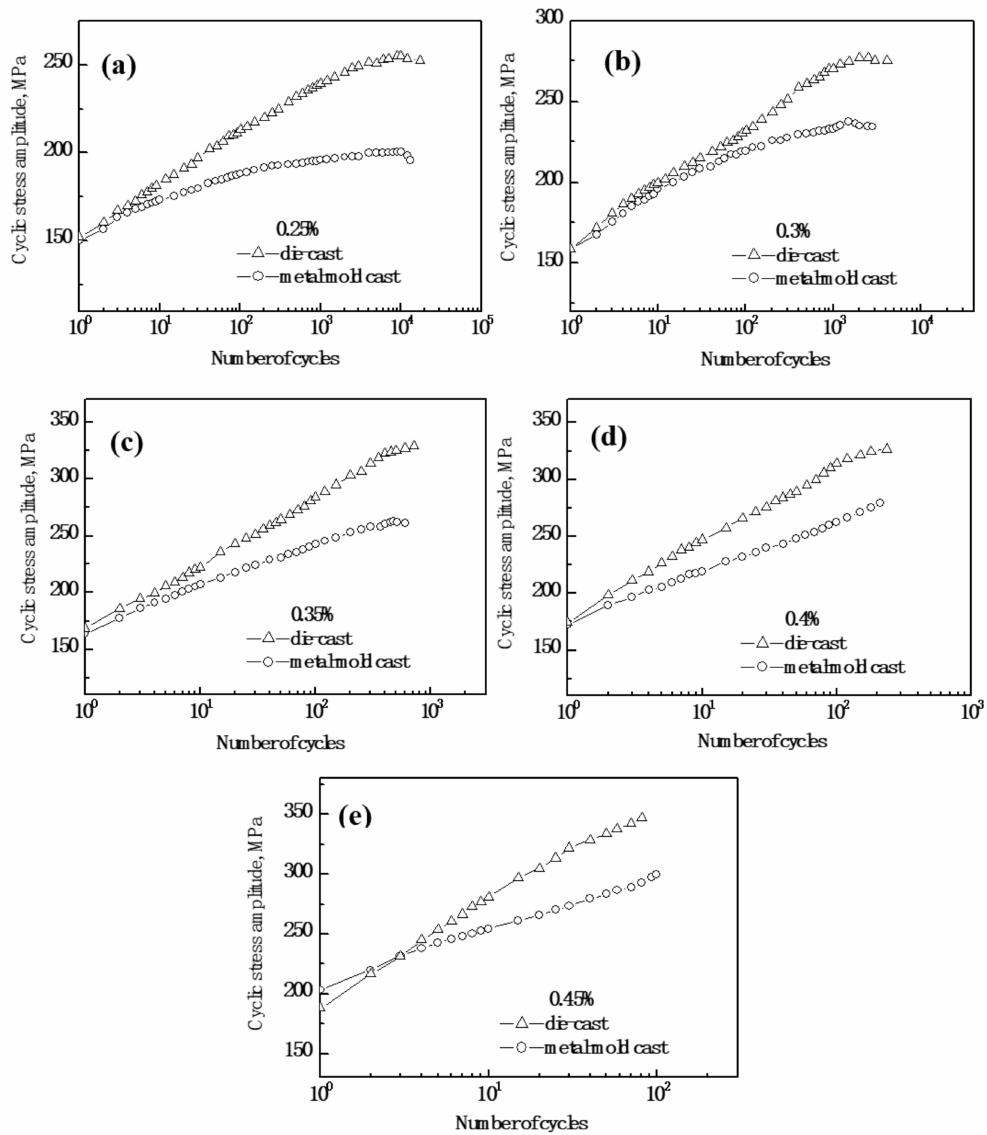
Figure 3. Cyclic stress response curves of metal-mold cast and die-cast Al-9Si-4Cu-0.4Mg-0.3Sc alloys at various total strain amplitudes. ( a ) 0.25%; ( b ) 0.3%; ( c ) 0.35%; ( d ) 0.4%; and ( e )